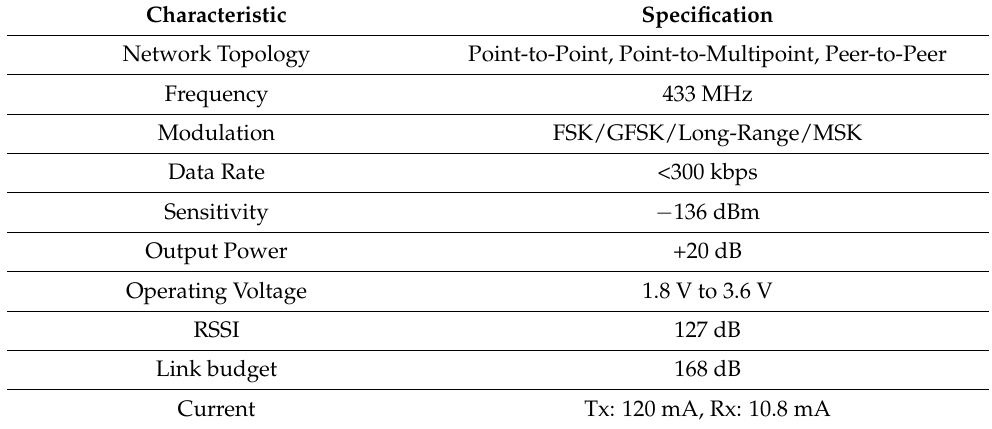
Table 2. SX 1278 Long-Range specifications [31].